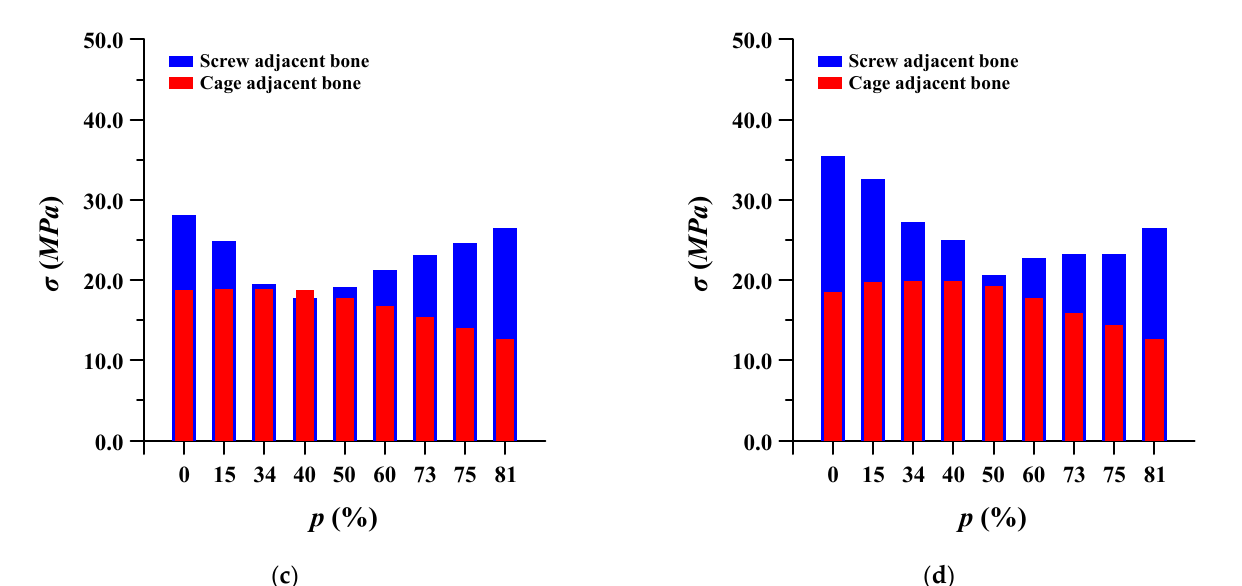
Figure 11. Equivalent stress ( σ ) at adjacent bone of pedicle screws and spinal cages at different porosities ( p ) of spinal implants in each spinal motion: ( a ) flexion; ( b ) extension; ( c ) lateral bending; and ( d ) rotation.